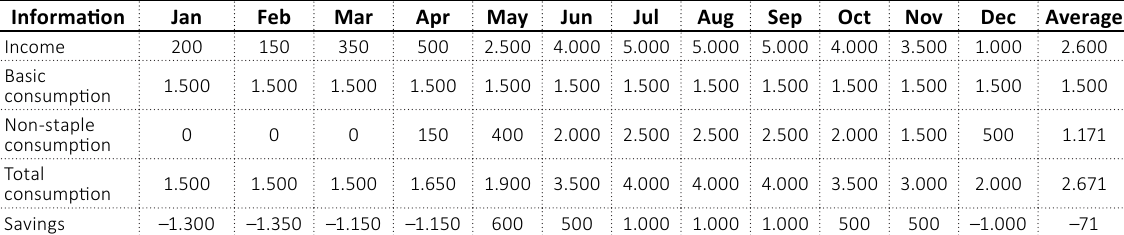
Table 1. The cycle of fisher’s income and consumption in Jepara, Demak, and Pati Regencies (000 Rp)